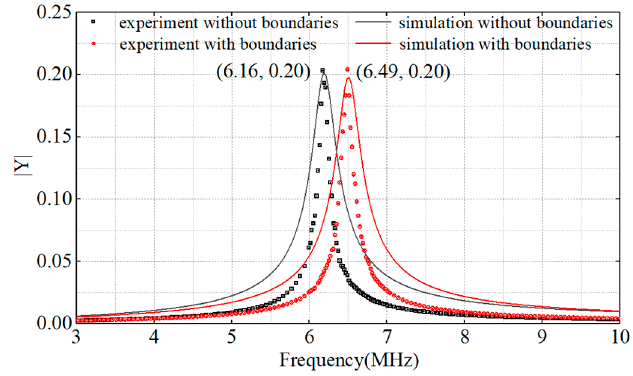
Figure 9. The impedance results of MTMs.